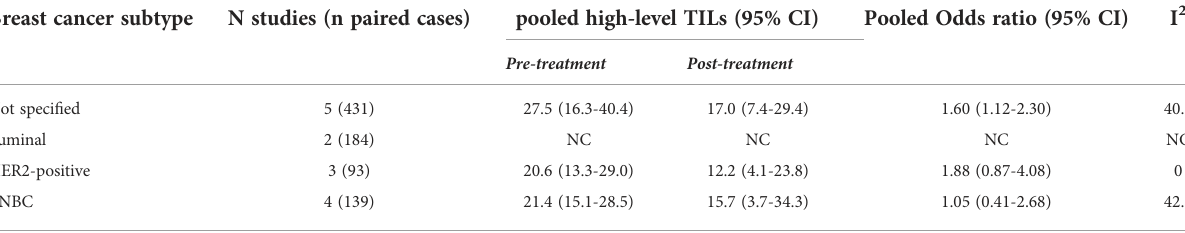
TABLE 2 Pooled expression of TILs pre- vs. post-treatment in matched breast cancer patients in studies presented TILs as categorical variable. Breast cancer subtype N studies (n paired cases) pooled high-level TILs (95%